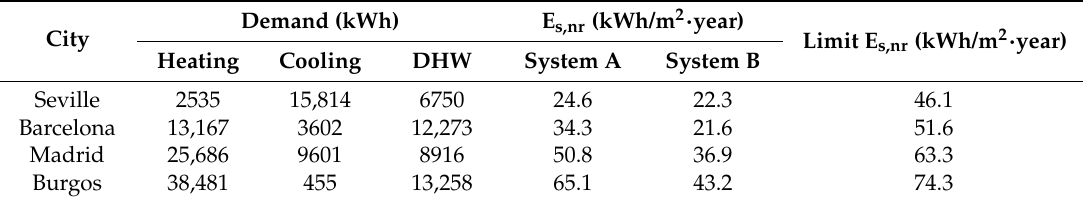
Table 5. Energy demands and non-renewable source energy consumption.